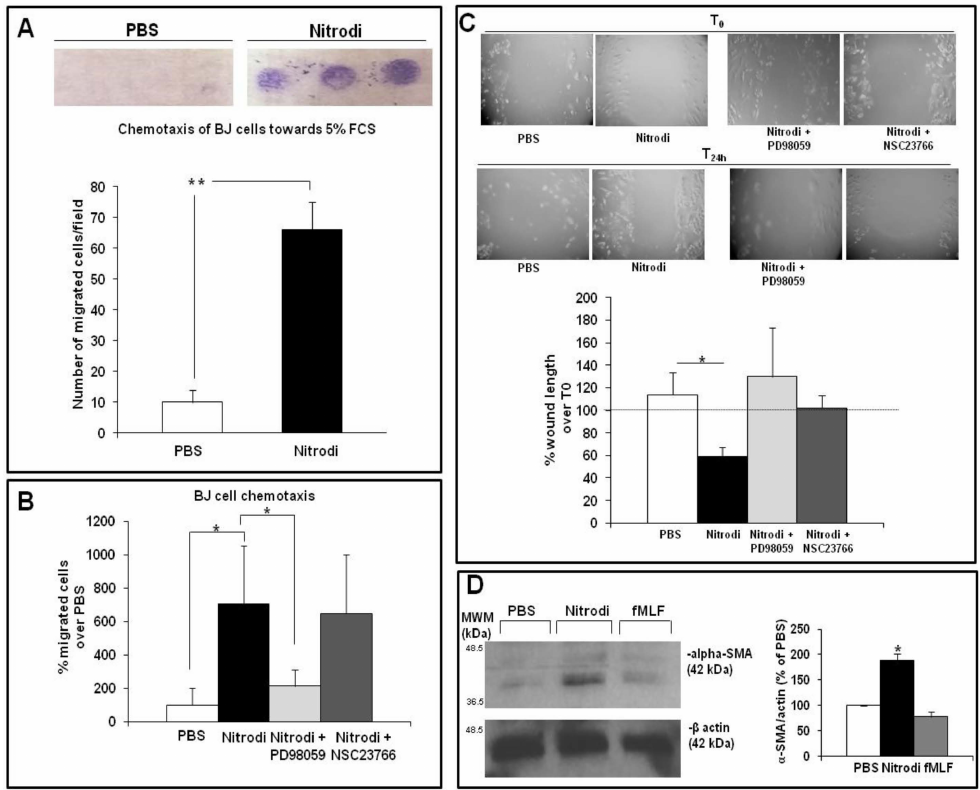
Figure 2. Effects of Nitrodi’s water on BJ cell migration. ( A ) Effects of PBS and Nitrodi on BJ cell chemotaxis. BJ cells were treated with PBS (white column) and Nitrodi (black column) and allowed to migrate towards 5% FCS for 24 h at 37 ◦ C in a humidified (5% CO 2 ) incubator. Error bars represent standard deviation of the mean of triplicate samples within one experiment. * p <